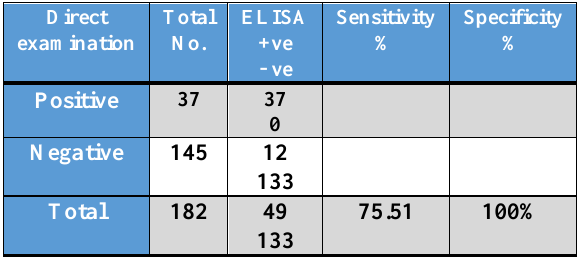
Table, 2: Sensitivity and specificity of ELISA versus direct examination method for Giardia lamblia